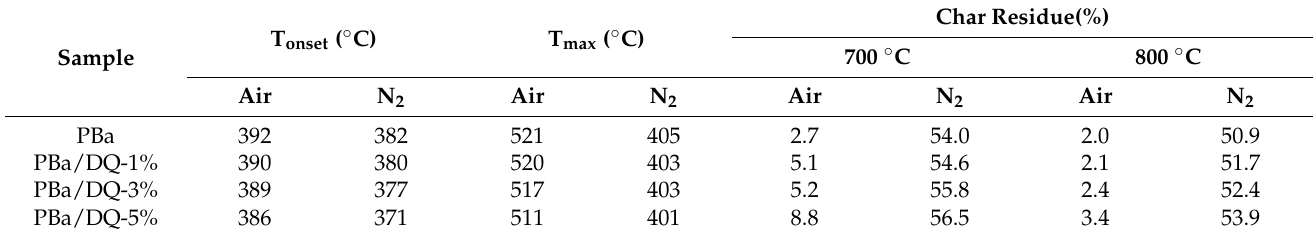
Figure 7. TGA of aerogels in the ( a ) Air; and ( b ) Nitrogen. Table 1. Results of thermal analysis of PBa and PBa composite aerogels in air and